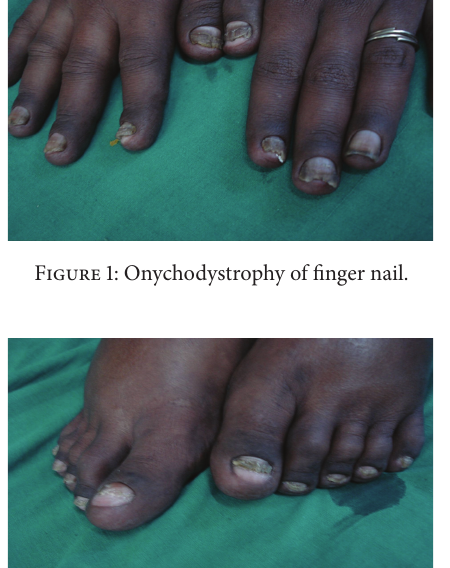
Figure 2: Onychodystrophy of toe nails.